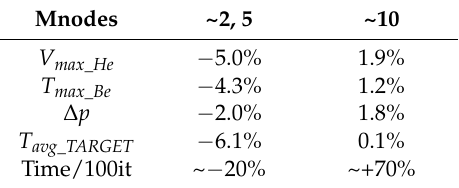
Table 4. Sensitivity analysis of grid size (5 Mnodes grid is the reference value).